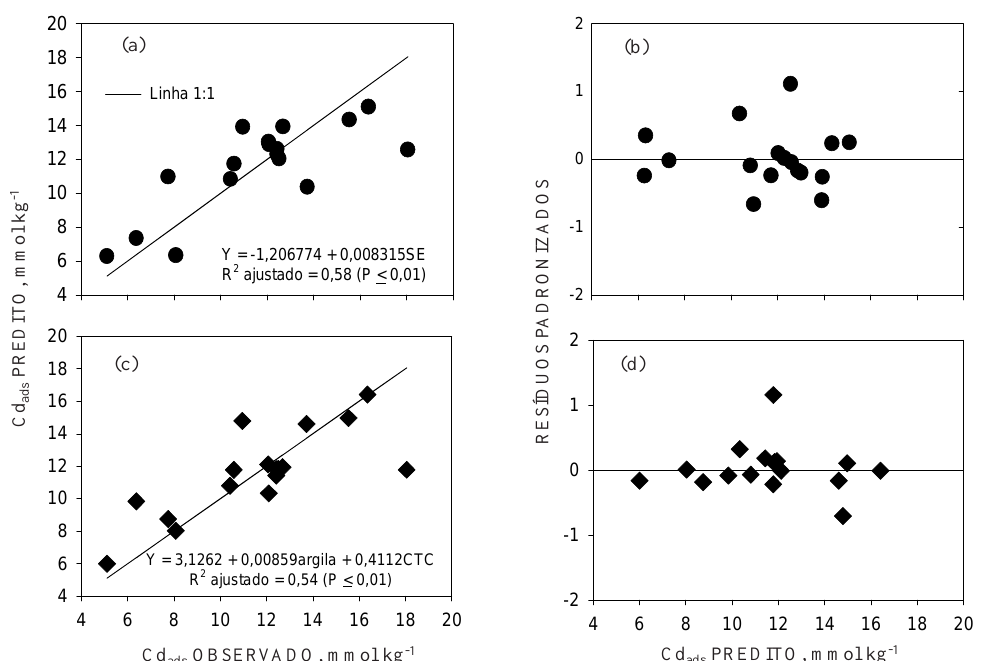
Figura 4. Relação entre a quantidade de Cd adsorvido observada em pH 6,5 e a quantidade predita pelo modelo que descreve a adsorção neste valor de pH, de acordo com a SE (a) e respectivos resíduos padronizados (b); relação entre os valores da quantidade de Cd adsorvido observada em pH 6,5 e a quantidade predita pelo modelo que descreve a adsorção de acordo com a CTC e teor de argila (c) e respectivos resíduos padronizados